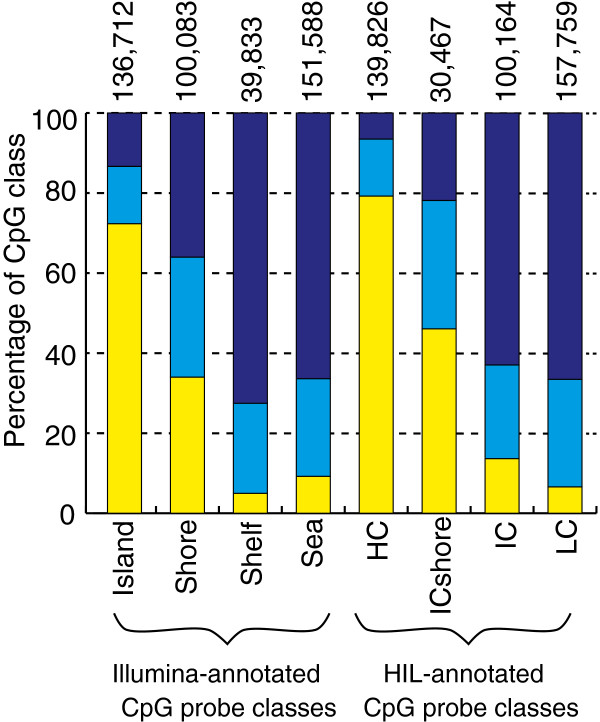
Distinct patterns of DNAm within CpG classification systems. Probes were grouped into three levels of DNAm based on average ß values within a tissue: hypomethylated (ß values of 0 to ≤0.2, yellow), heterogeneously methylated (ß values of >0.2 to <0.8, light blue) and hypermethylated (ß values of ≥0.8 to 1, dark blue). The percentage of probes in Illumina and HIL-annotated CpG classes was plotted for the three levels of DNAm in blood (n = 4). HIL CpG classes were more characteristic in their DNAm profiles than Illumina-annotated CpG classes. Numbers on top of bars indicate number of probes/class. DNAm, DNA methylation; HIL, high-density CpG island (HC), intermediate-density CpG island (IC) and non-island (LC); ICshore, intermediate-density CpG island shore.